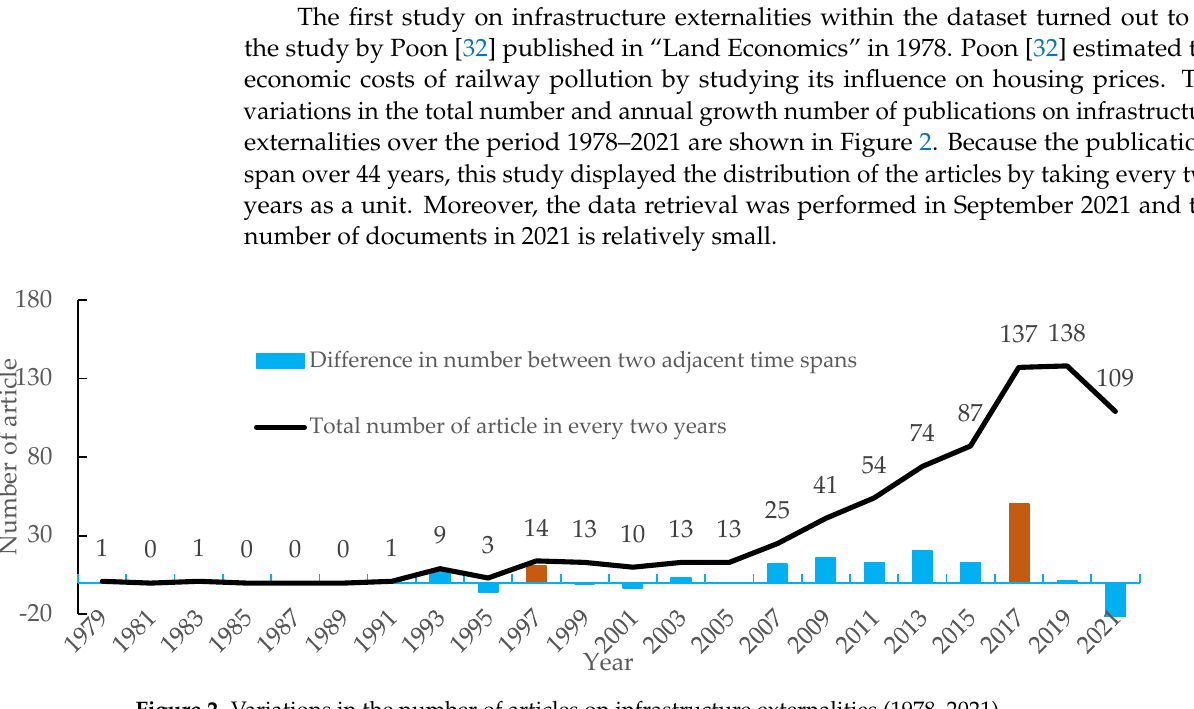
Figure 2. Variations in the number of articles on infrastructure externalities (1978–2021).